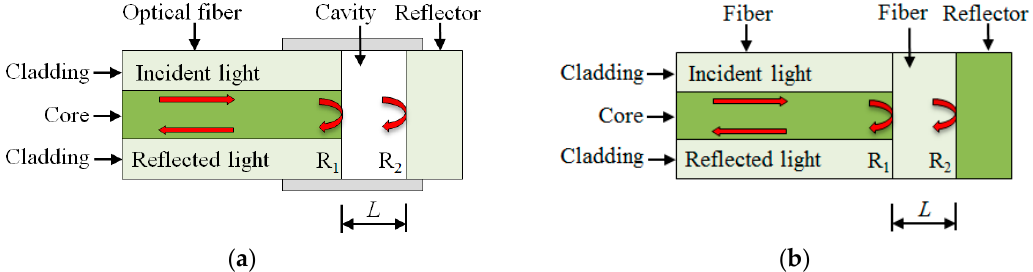
Figure 5. Illustration of Fabry-Perot Interferometers (FPIs): ( a ) Extrinsic (E)FPI; ( b ) intrinsic (I)FPI.